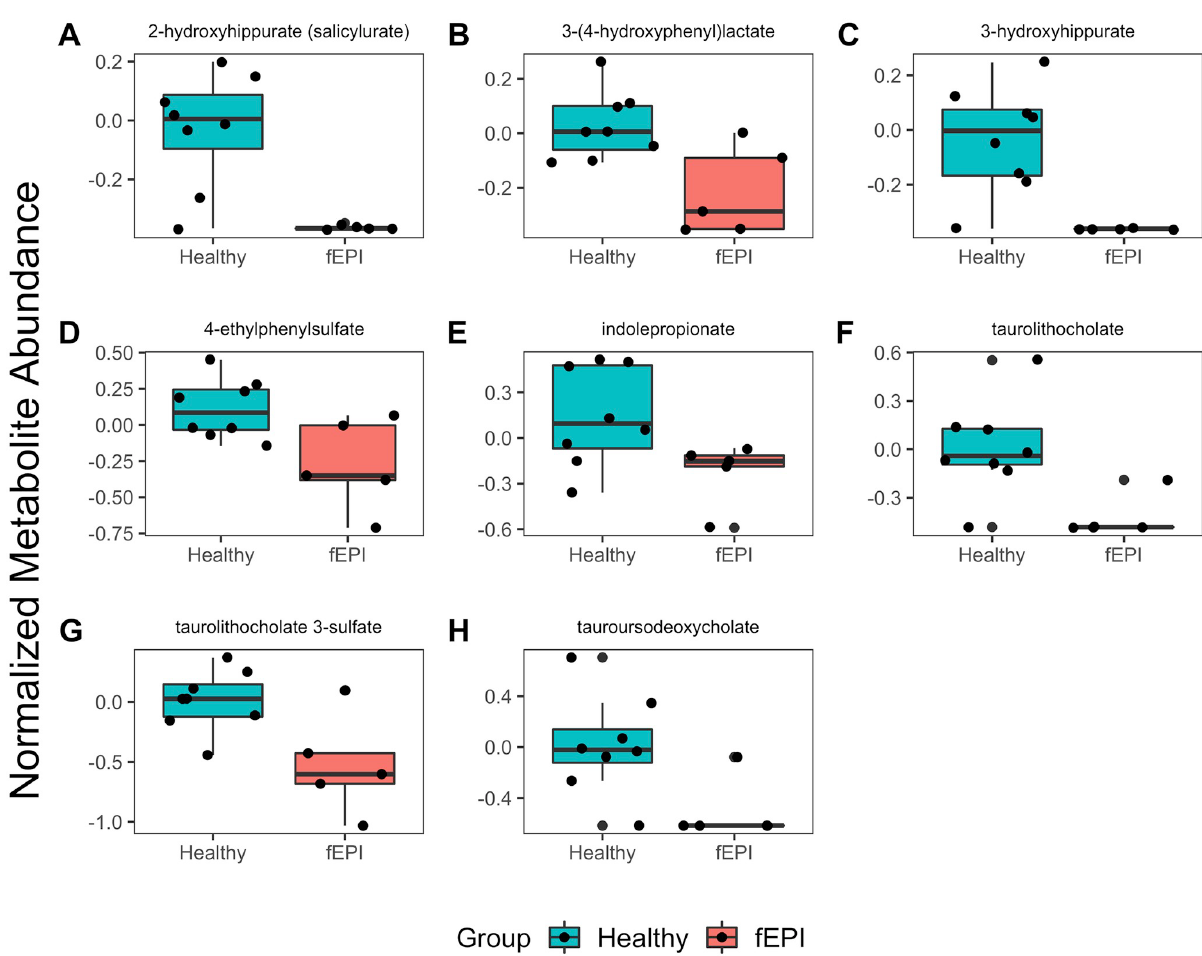
Fig 4. Comparison of serum microbial metabolites between cats with EPI and healthy controls. The abundance of several serum microbial metabolites were decreased in cats with EPI compared with healthy controls. On the y-axis are the normalized (median scaled and log-transformed) abundance of each serum